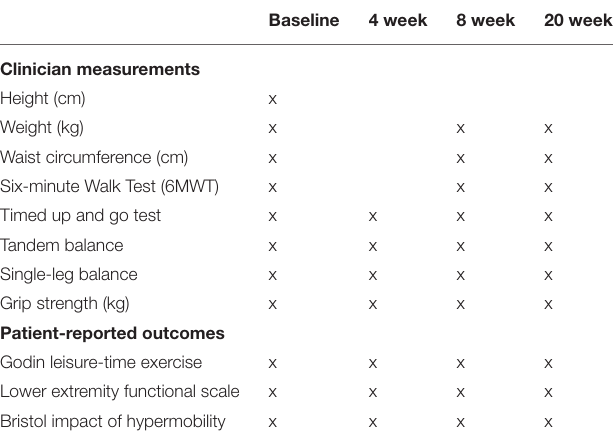
TABLE 3 | Clinical research measurements at given assessment periods of GEAR.